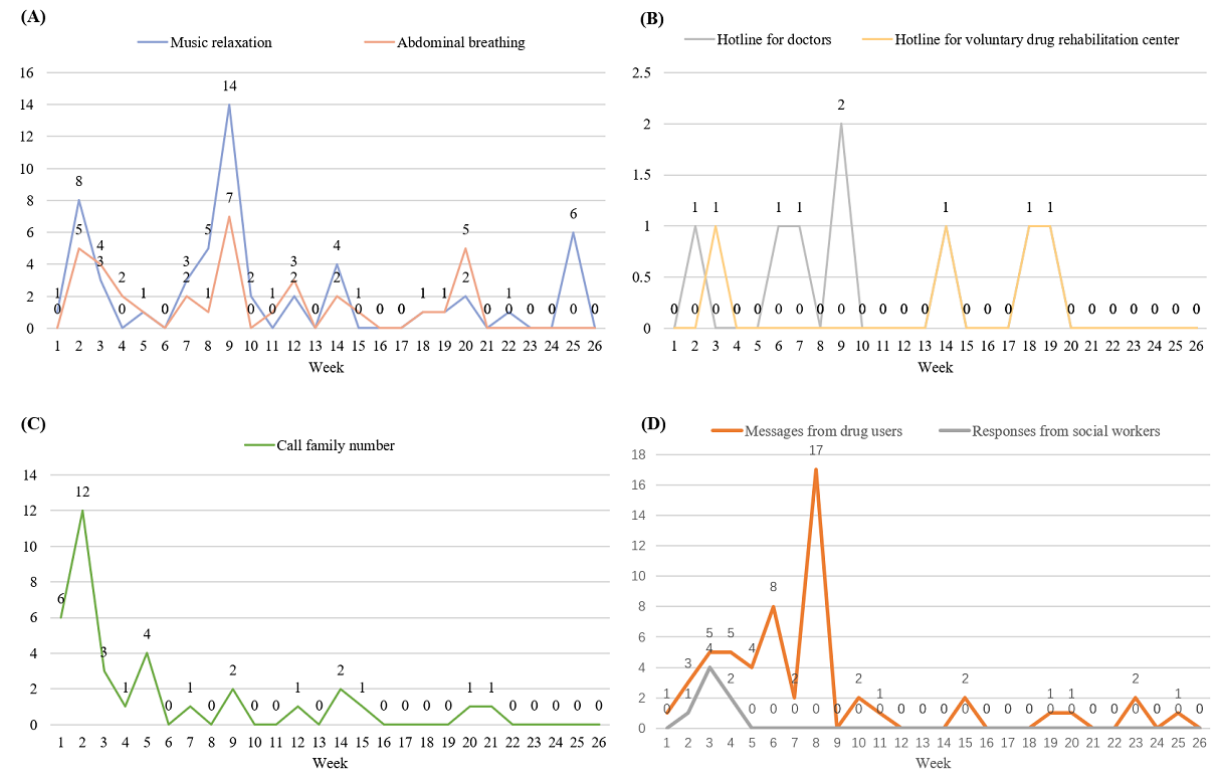
Figure 5. Mean number of times of SOS features per week: (A) relaxation training (including music relaxation and abdominal breathing); (B) call forwarding service to doctors and voluntary drug rehabilitation center; (C) call forwarding service to family members; (D) message board used in both drug user and social worker